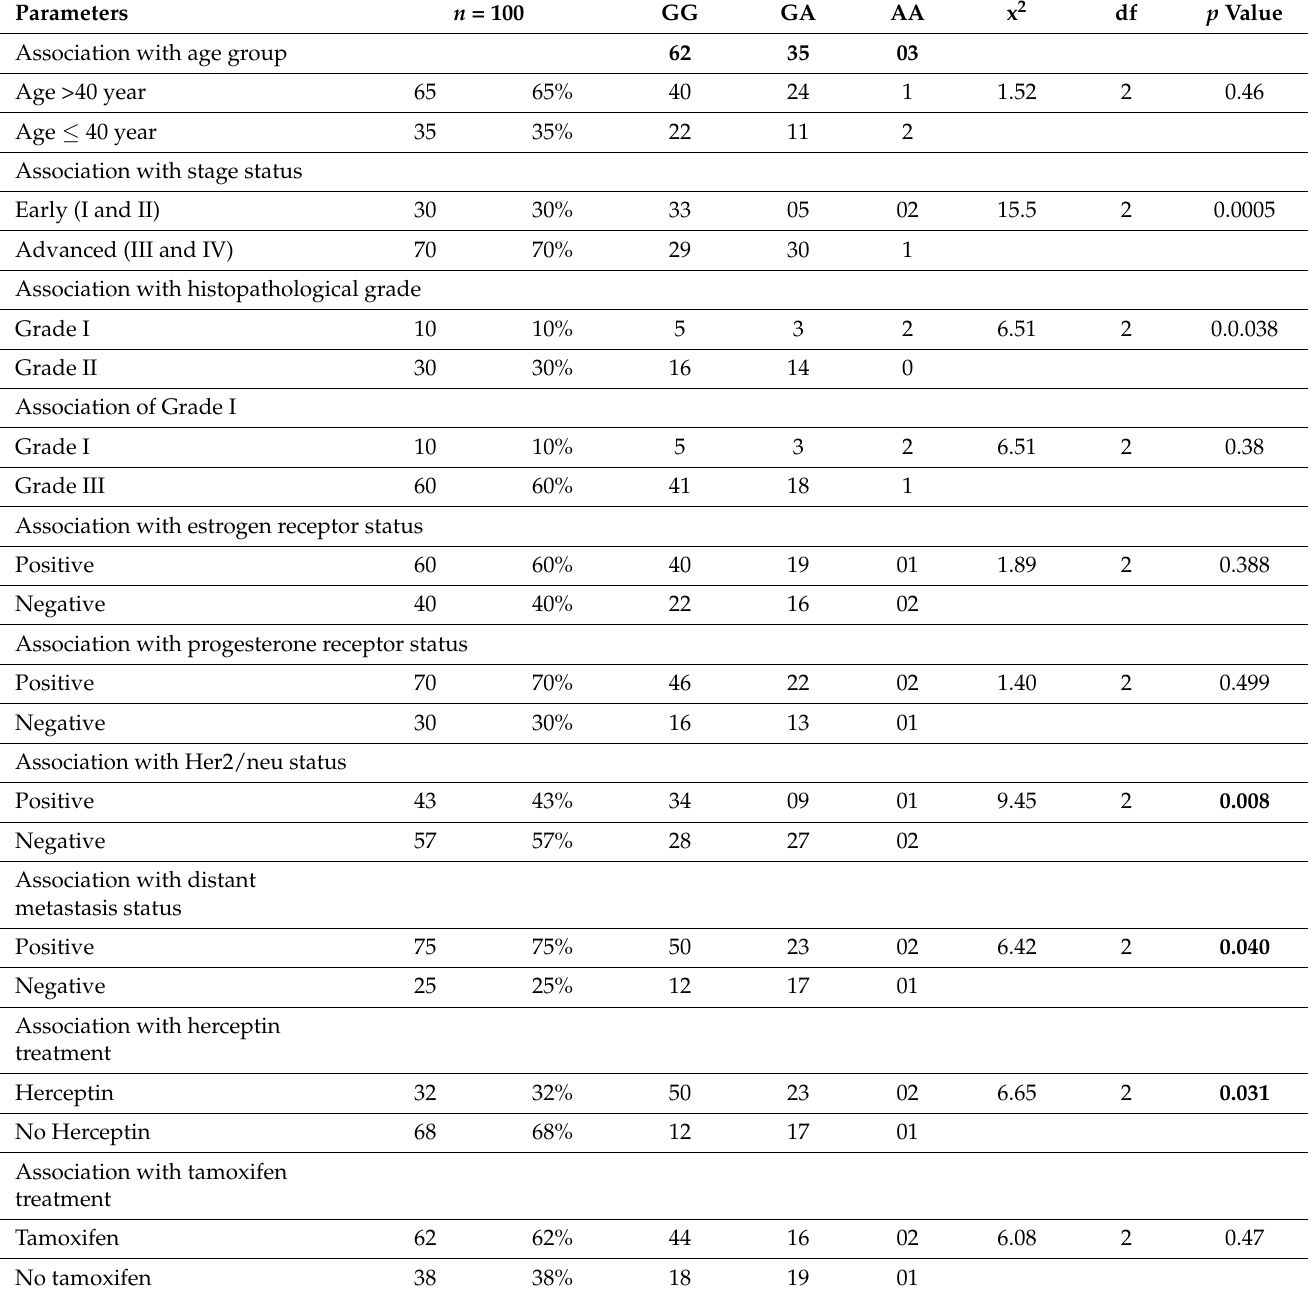
Table 11. MDM4 rs11801299 G > A genotypes’ association with the clinicopathological characteristics of breast cancer patients. p values in bold are